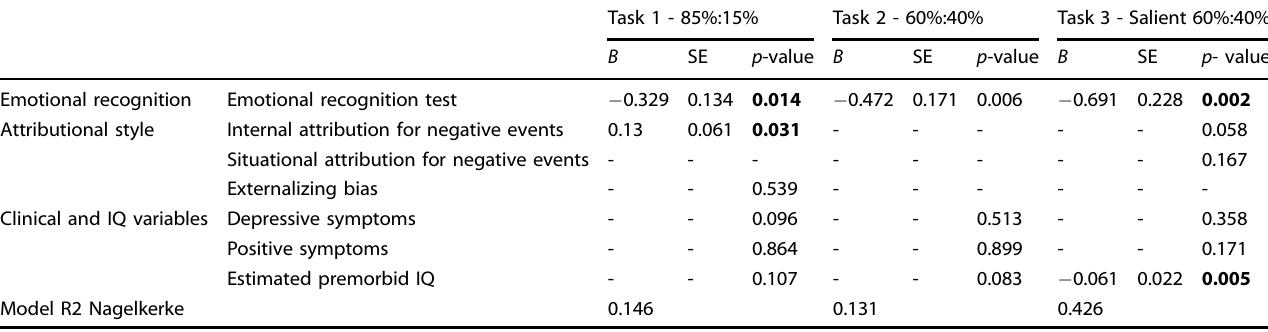
Table 4. Logistic regression model of social cognition and clinical variables associated with jumping to